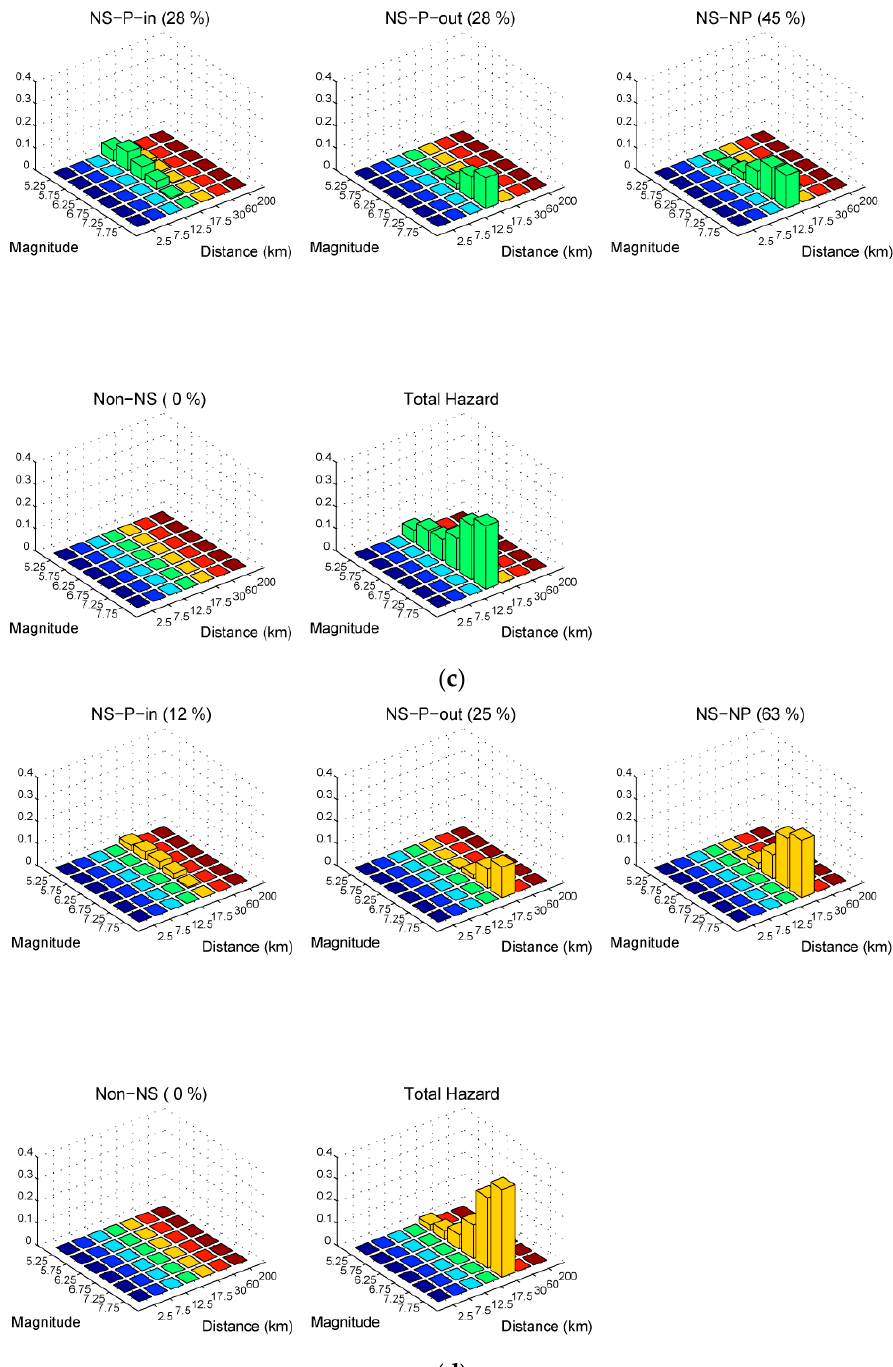
Figure 14. Distance-magnitude deaggregation plots from the time-domain analyses at a drift of 1% for sites located at a distance of ( a ) 6 km, ( b ) 11 km, ( c ) 16 km, and ( d ) 21 km. Results are shown separately for the total hazard and for the different components of the time-domain analyses. The labels for the components are: NS-P-in—Near-source pulse motions with pulses dominant; NS-P-out— near-source pulse motions with non-dominant pulses; NS-NP—near-source motions without pulses; and Non-NS—non-near source motions. The value in parenthesis is the total contribution to hazard for each component.